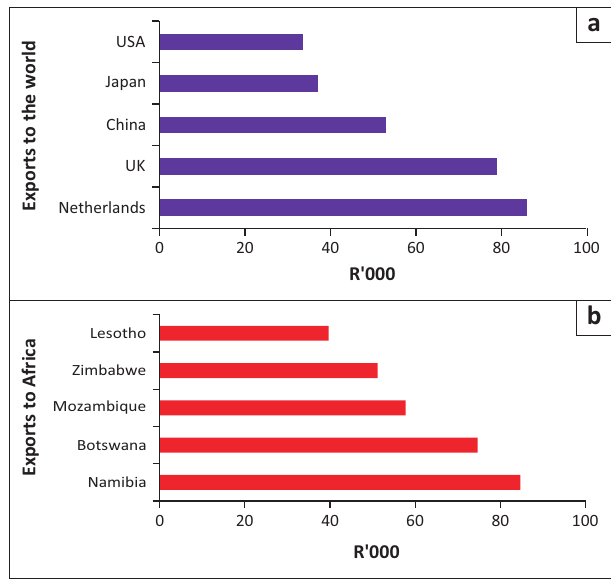
FIGURE 1: South Africa’s major agricultural, fisheries and forestry (AFF) exports and imports from Africa (a–b) (2014–2018).